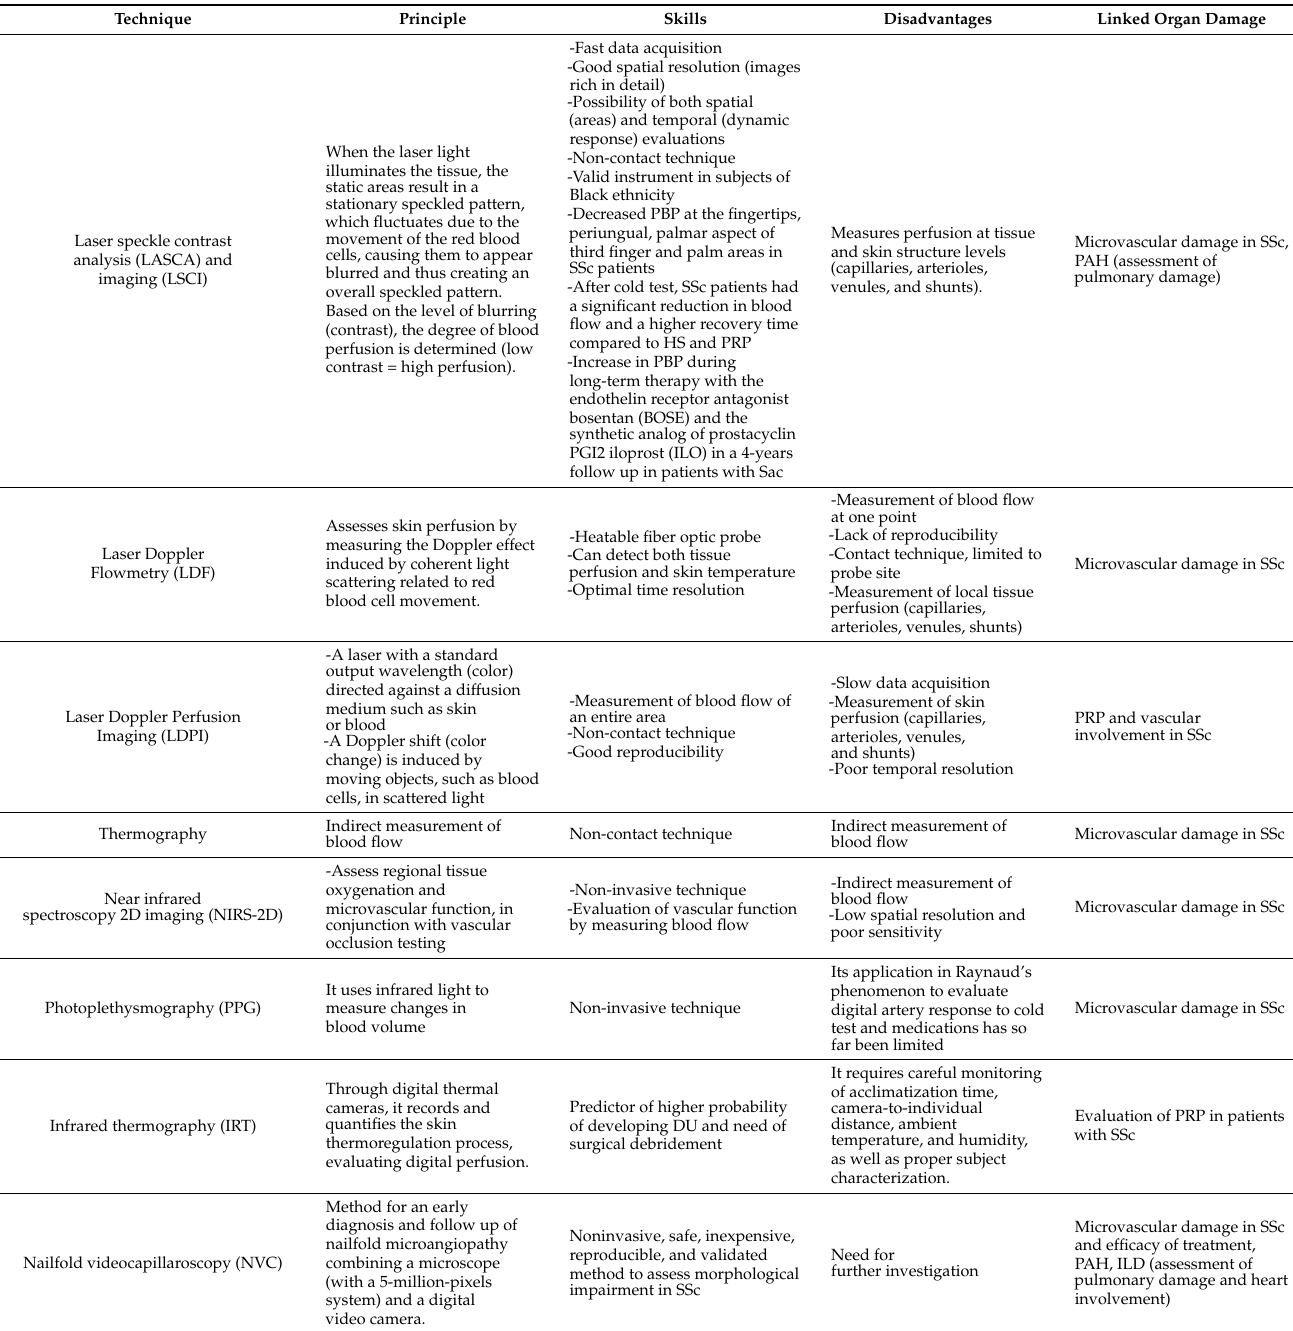
Table 1. Main characteristics of available techniques to evaluate morphological and functional microvascular